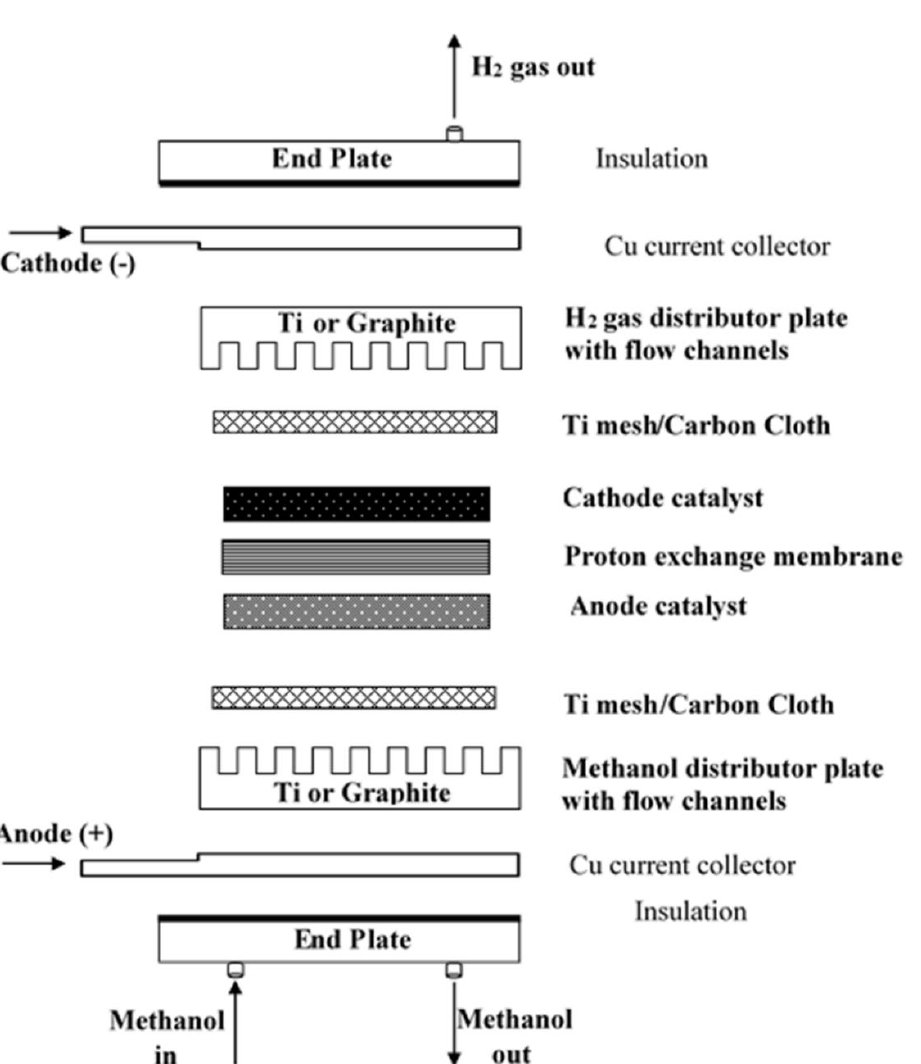
Figure 3. Components of PEM methanol electrolyzer.